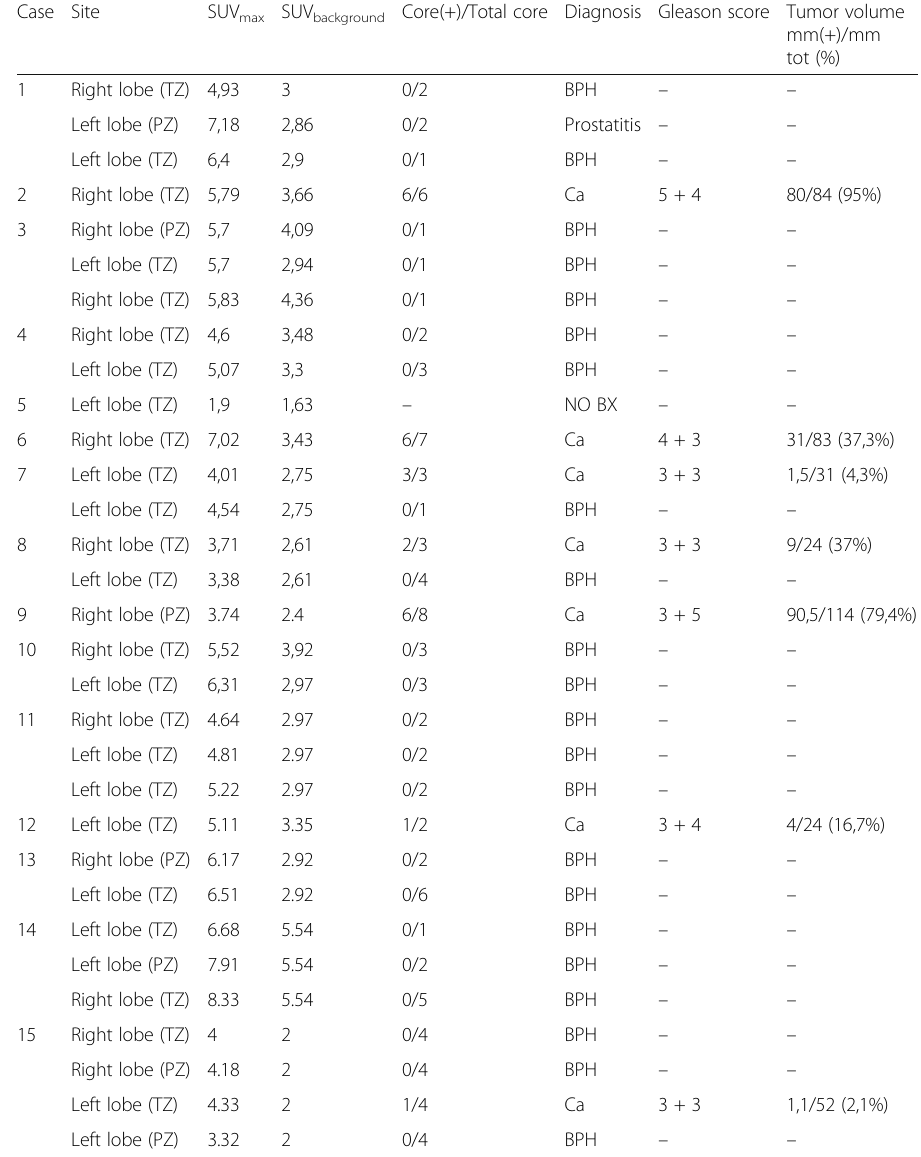
Table 1 PET-CT outcome and pathological characteristics of biopsies for all the patients (TZ = transition zone; PZ = peripheral zone) Case